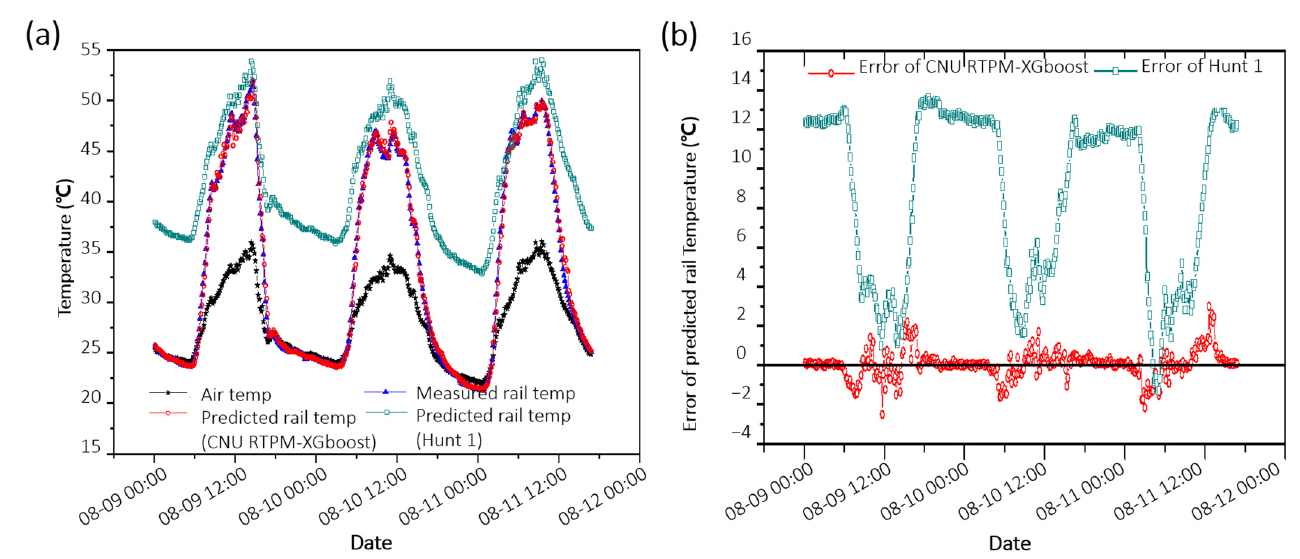
Figure 7. ( a ) Comparison of the predicted rail temperature and the measured rail temperature graphs. ( b ) Error of predicted rail temperature in August 2016.